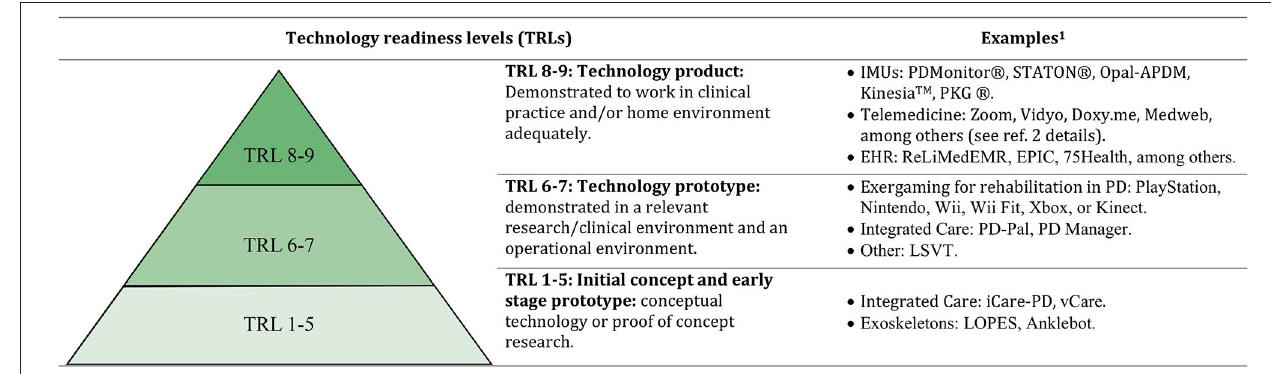
FIGURE 1 | Technology readiness levels (TRLs) and systems mentioned in the review. IMUs, Inertial Measurement Units; EHS, Electronic Health Records; LSVT, Lee Silverman Voice Treatment Device; LOPES, Lokomat, ReoAmbulator, Lower Extremity Powered ExoSkeleton. 1 Based on two authors’ (MHGM, ASF) consenus